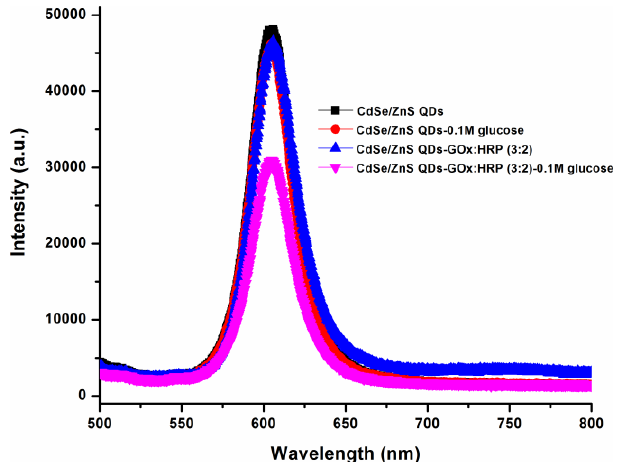
Figure 6. The fluorescence spectrums of CdSe/ZnS QDs along with different combinations of its loading with GOx:HRP enzyme and in the presence of 0.1 M glucose. All spectra were recorded after mixing the components for 30 min.